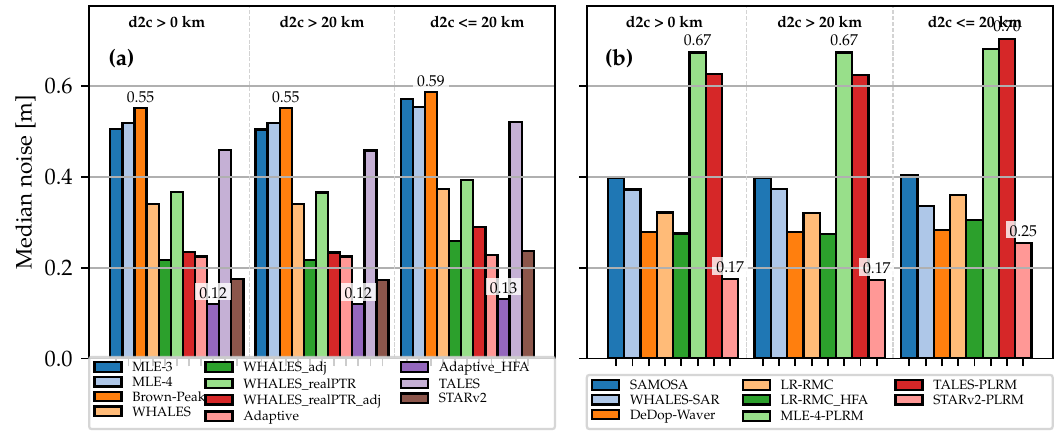
Figure 6. Median noise as a function of dist2coast for ( a ) J3- and ( b ) S3A-retracking algorithms.